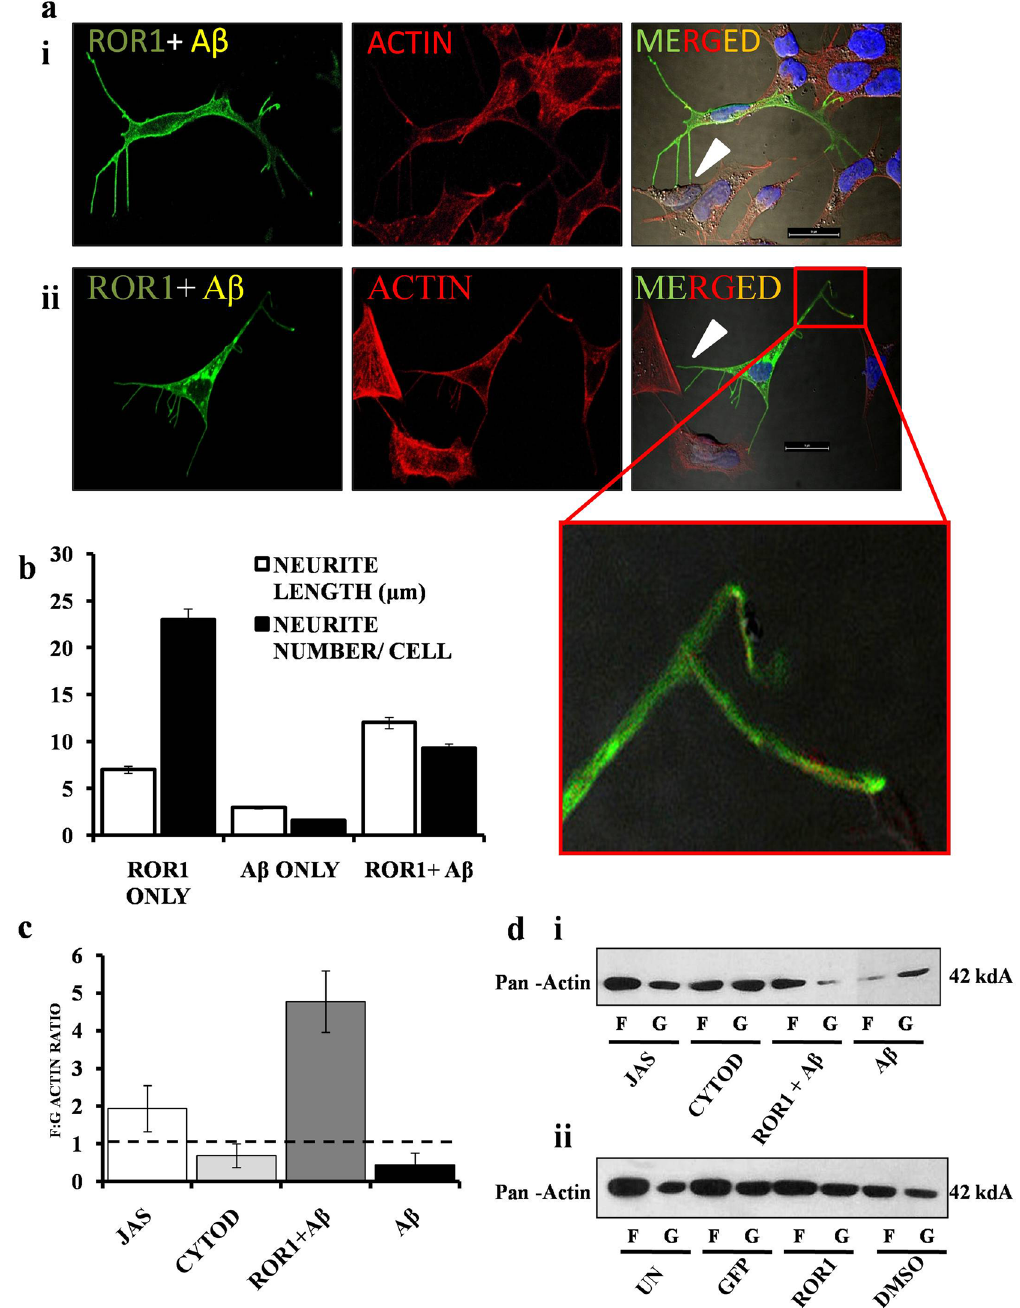
Figure 3. Effect of ROR1 on neurite elongation and actin ratio in Aβ 1–42 treated cells. ( a ) Confocal microscopy images of SHSY-5Y cells transfected with ROR1-GFPSpark, treated with Aβ 1–42 and stained with DAPI—panel i, ii and inset. ROR1 + Aβ 1–42 leads to fewer but more elongated neurites which makes contact with adjacent cells (white wedge), Scale bars, 10 μm; For each confocal experiment, images of at least 30 cells (or cell fields) were captured and the experiments were repeated thrice (n = 3). ( b ) Graph depicting the mean value of neurite length and neurite numbers in ROR1, Aβ 1–42 and ROR1 + Aβ 1–42 cells. ( c ) Graph depicting the mean value of F: G actin ratio in Jasplakinolide, Cytochalasin-D, ROR1 + Aβ 1–42 and Aβ 1–42 treated cells, compared to their respective controls. ( d ) (i) Western blot (n = 3) showing the Pan -actin levels in the F and G fractions of cells treated with Jasplakinolide, Cytochalasin-D, ROR1 + Aβ 1–42 and Aβ 1–42 . (ii) Western blot (n = 3) showing the Pan -actin levels in the F and G fractions of untreated cells, GFP transfected cells, ROR1 transfected cells and cells treated with DMSO. In each case, F: G ratio (y-axis) > 1. Error bars indicate ± SD. Significance level between different experimental pairs is shown (NS, not significant; * p < 0.05; ** p < 0.01; *** p <